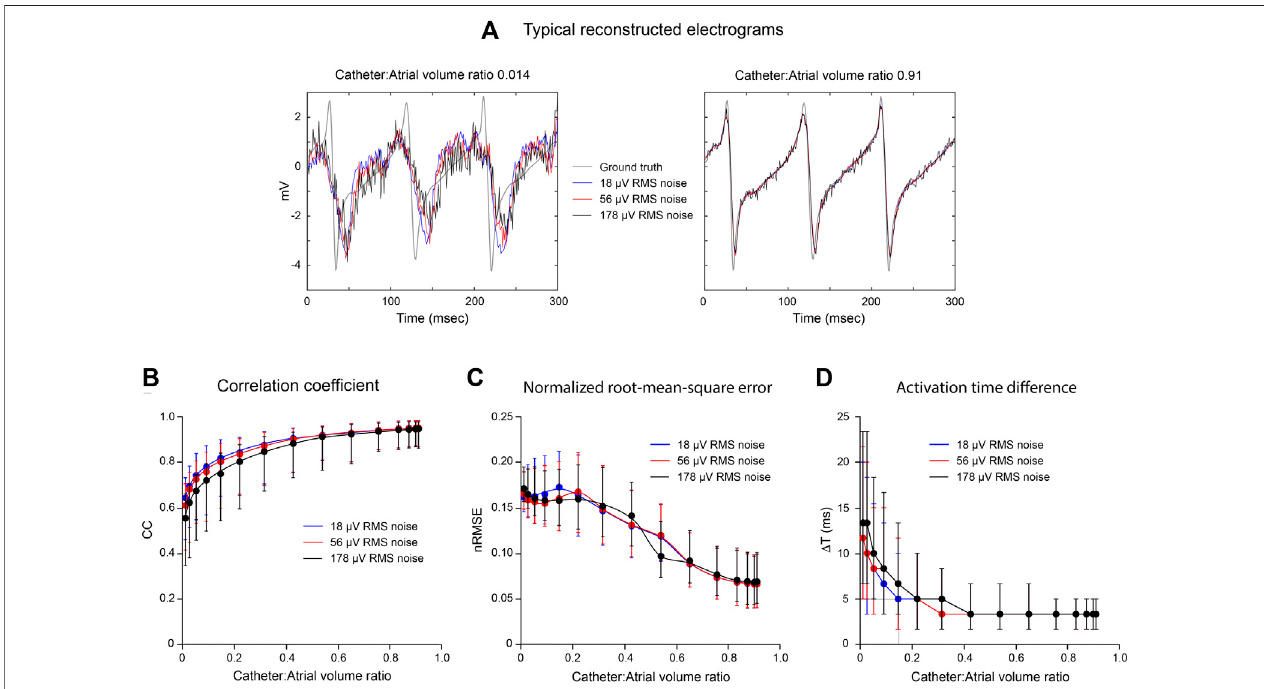
FIGURE 4 | Effects of noise on inverse solutions with the MFS during macro reentry. LA surface potentials throughout activation cycle in simulated atrial fl utter are reconstructed from electrograms sampled inside the LA cavity using 130-electrode basket catheters with added Gaussian noise at different mean power levels. All data are compared with ground-truth endocardial potentials. In the upper panel (A) electrograms reconstructed from records acquired from a very small and a large basket catheterwith18,56and178 μ Vofaddednoisearepresented withthecorrespondingground-truthelectrogram.Catheter volumesrelativetoLAvolumeare0.014 and 0.91, respectively. In the lower panel, CC (B) , nRMSE (C) and Δ T (D) are presented as functions of relative catheter volume for the three noise levels. Median values and IQR are given. Abbreviations: LA, left atrium; CC, correlation coef fi cient; nRMSE, normalized root-mean-squared error; Δ T, activation time